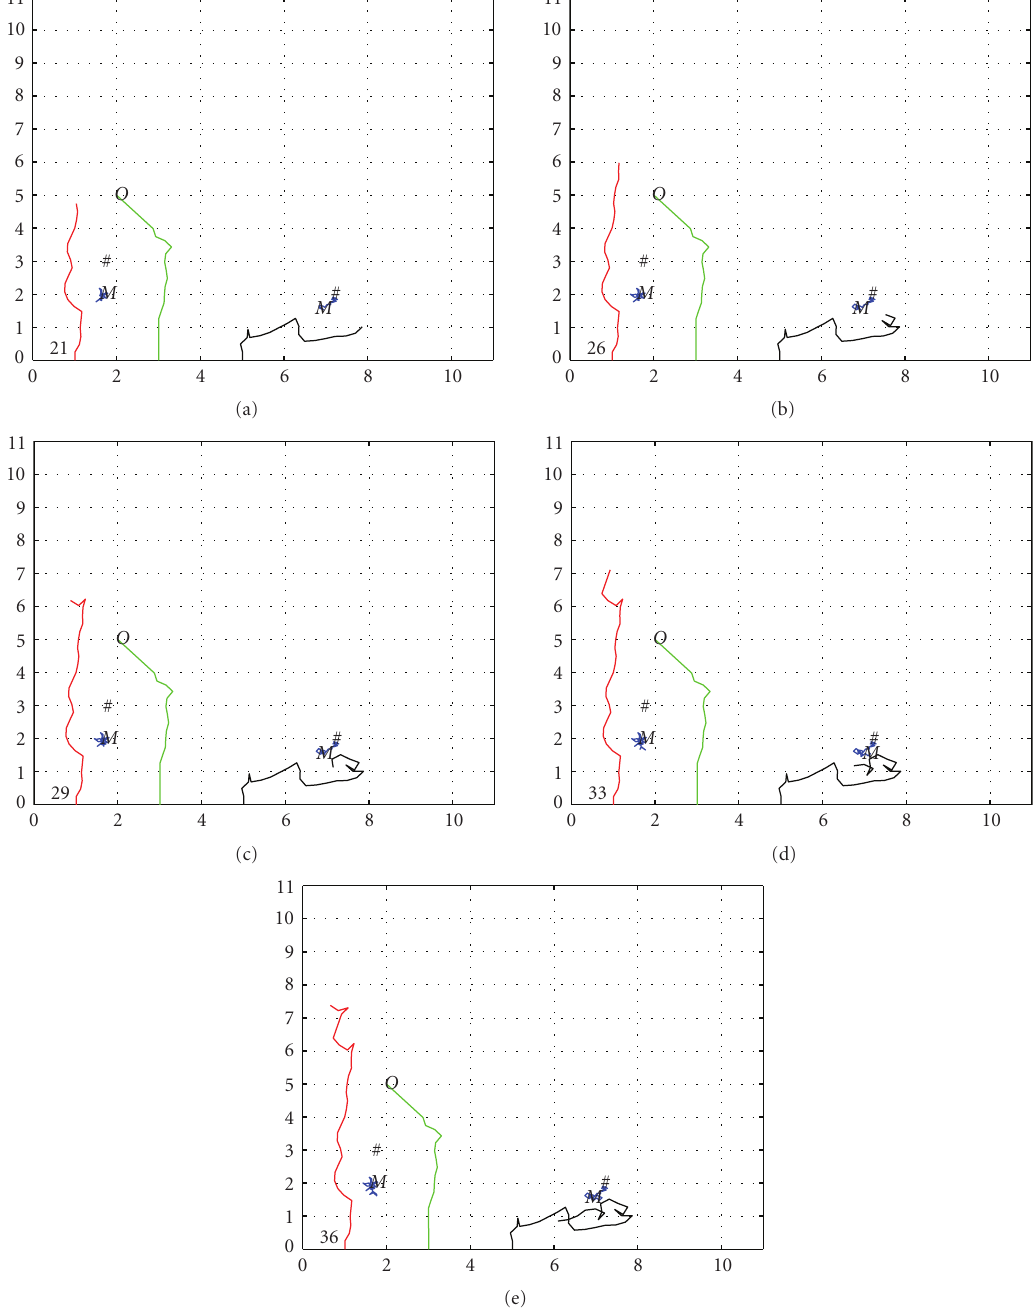
Figure 11: (a) R 1 spots a moving obstacle in the way. and start moving obstacle avoidance algorithm for their navigation. (b)–(e) shows for each step, the robot is moving away from the current position the obstacle therefore avoiding collision. Meanwhile the total e ff ects of attractive “force” from the unsearched cells and the objects attract the robot towards to the